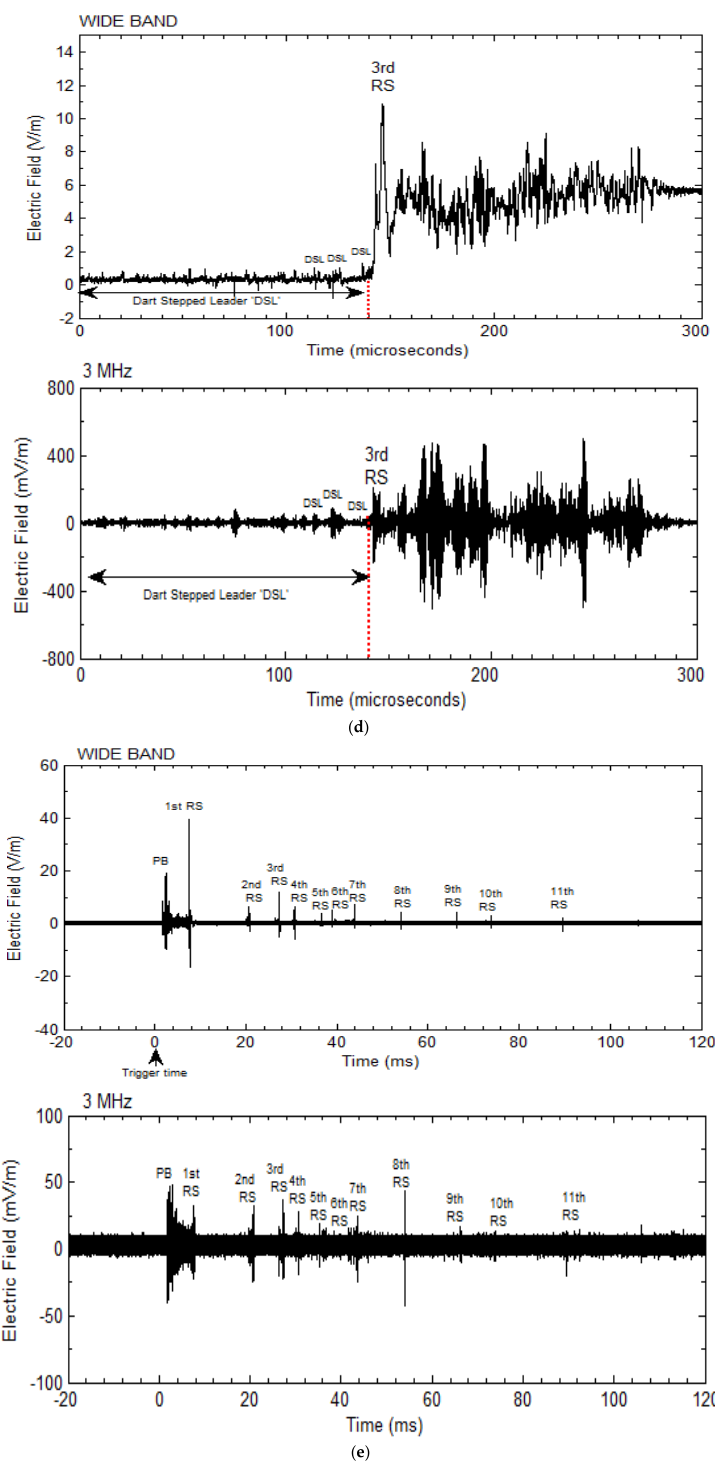
Figure 7. ( a ) A sample of SRS peak larger than first RS, recorded on 21/7/2014 at 16:56:12:679,187. The distance from the measuring station to the first stroke location (59.80380°N, 17,74230°E) was about 8 km. ( b,c,d ) shows three return strokes from Figure 7a on smaller time scales respectively. Note that the slow field changes are also visible and stepped leader (SL) and dart-stepped leader (DSL) are marked. ( e ) Maximum stroke multiplicity in Sweden 2014 measurement campaign together with 3 MHz, recorded on 21/07/2014 at 15:34:54:829297. The distance from the measuring station to the first stroke location (59.7350° N, 17.5280° E) was 13.5 km.